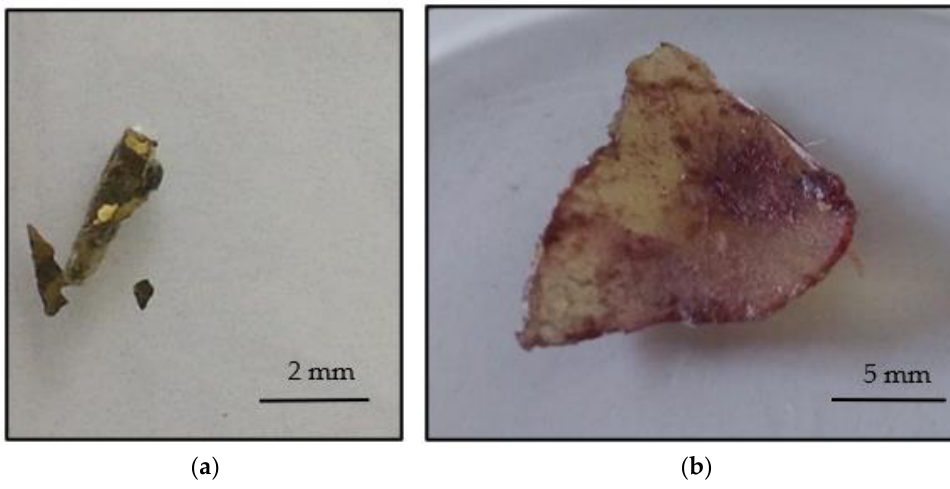
Figure 2. ( a ) Brass tiles and ( b ) Glue